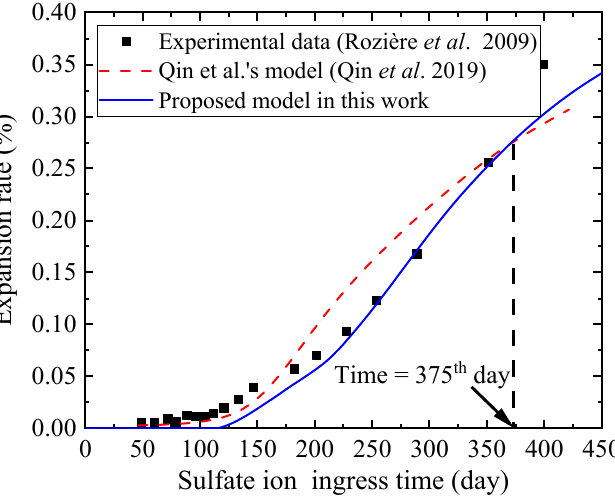
Figure 8. Concrete expansion rates measured by experiments and numerical simulations.